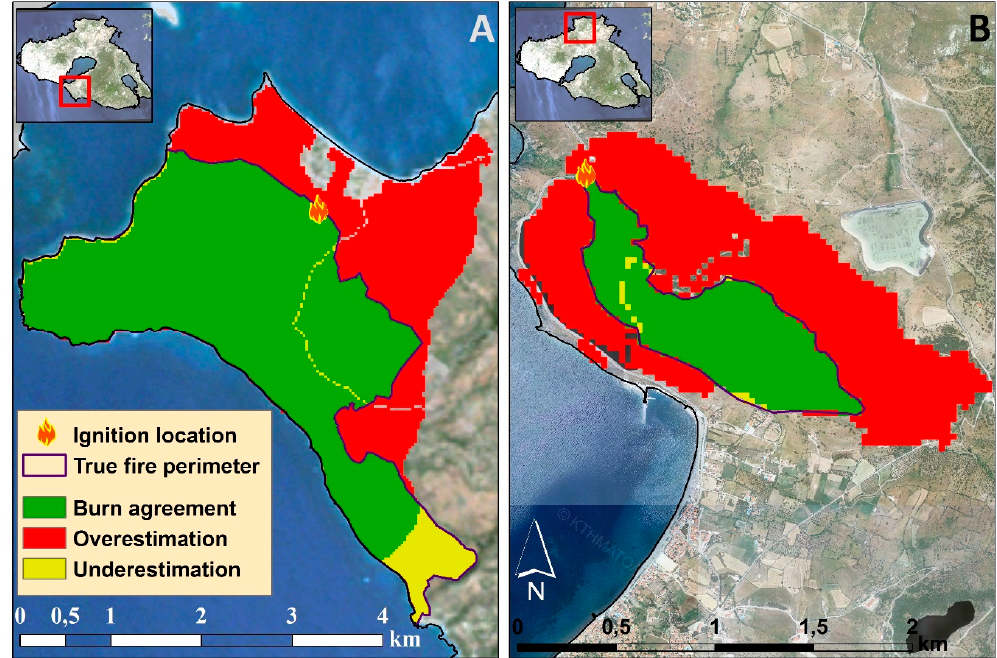
Figure A4. FARSITE simulation results using the standard Scott and Burgan [51] fuel models for fires that burned mostly on olive groves and grass–shrub fuel types. ( A ): South fire; ( B ): north fire. As a final note, the stochastic fire simulation results of 10,000 ignitions on the base conditions revealed that the largest simulated fire matched the size of the largest historical fire in the study area (~2500 ha). The average fire size of all simulated large fires (8700 fires burning >50 ha; standard deviation 522 ha) with a 90% confidence level is 622 ± 9.2 (±1.5%) [612.8–631.2 ha]. The